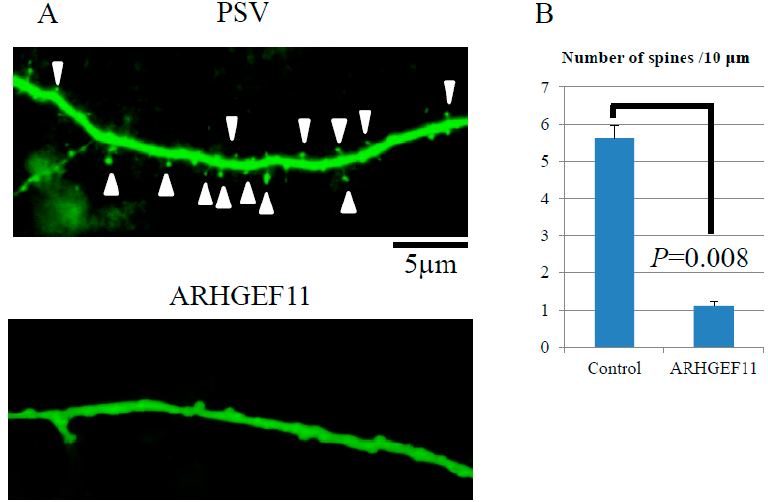
Figure 4. Regulation of spine formation by ARHGEF11. pSuper Venus (green) and Exo-ARHGEF11 construct were transfected in cortical neuron at 26 days in vitro. After the immunofluorescent cell staining at 28 days, the number of dendritic spines was analyzed over 10,000 µm of dendritic tissue from eight independent experiments using Lumina Vision. Overexpression of Exo-ARHGEF11 significantly decreased the number of spines ( p = 0.008) ( A , B ). White arrows indicate spines.